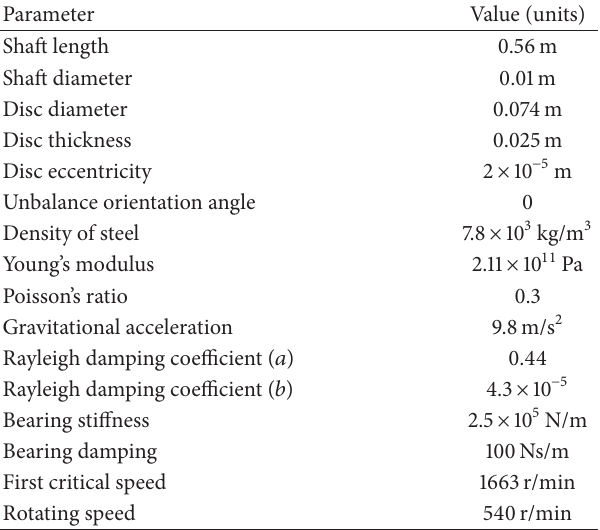
Table 1: Parameters of the cracked